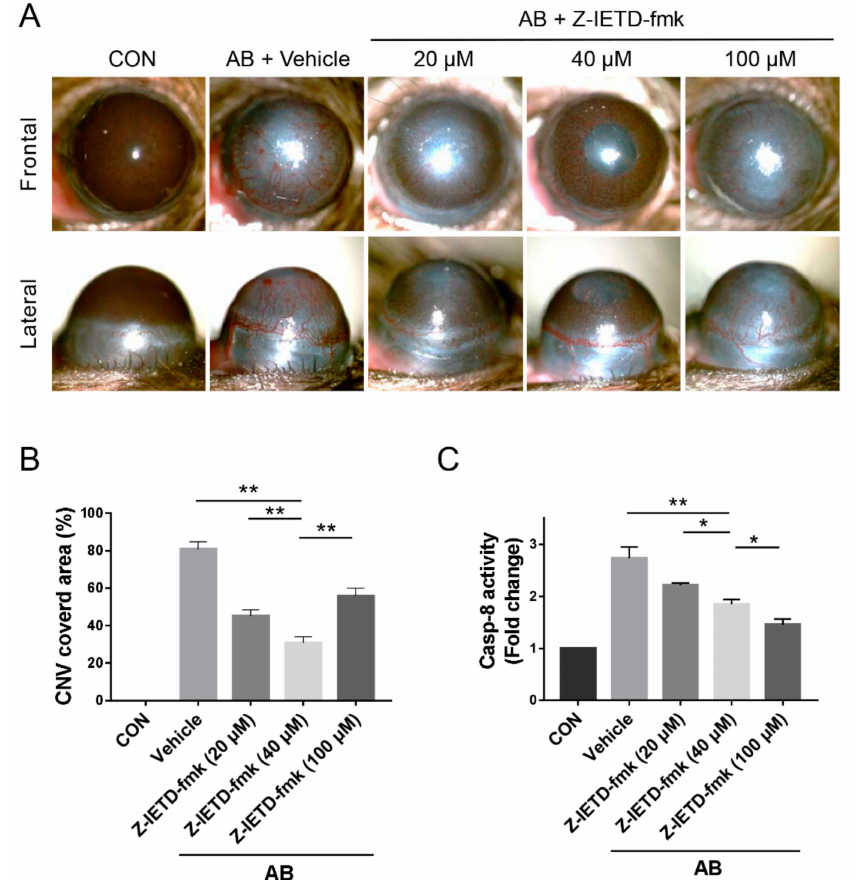
Figure 2. Pharmacological inhibition of caspase-8 suppressed CNV after corneal AB. ( A ) Representative images of the macroscopic CNV appearance after vehicle / Z-IETD-fmk treatment on day 14 after corneal AB injury. ( B ) Statistical analysis of the CNV covered area after vehicle / Z-IETD-fmk treatment ( n = 6). (C) Colorimetric assay of caspase-8 activity in corneas ( n = 3). The data are presented as the mean ± SD. * p < 0.05, ** p <